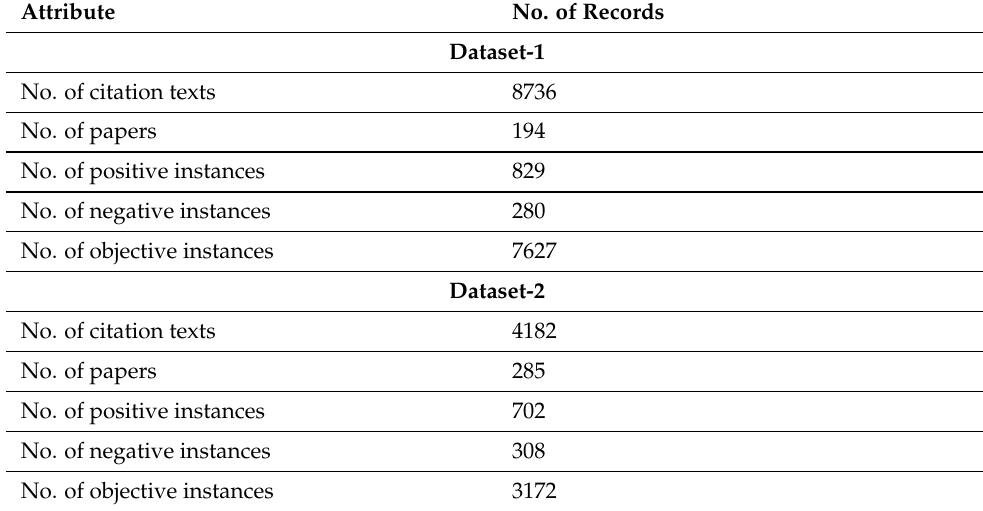
Table 1. Details of citation sentiment